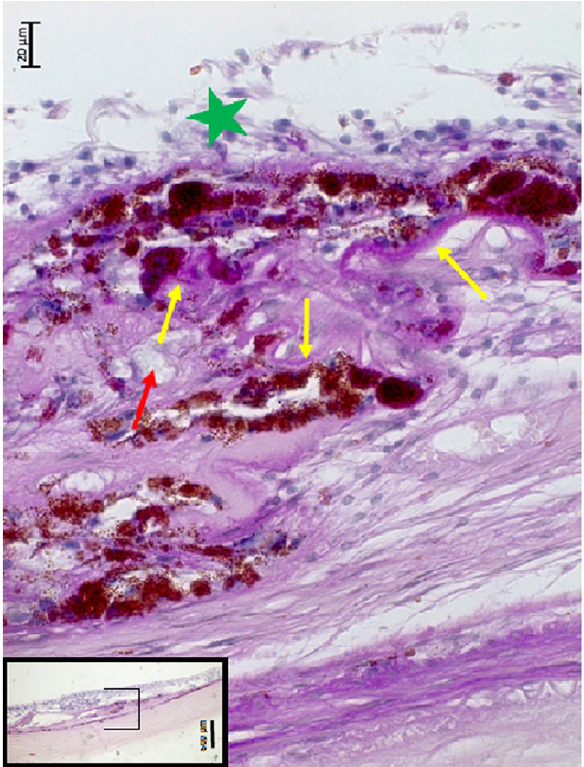
Figure 1. Histophotograph showing a neovascular myopic macular degeneration with irregular proliferations of irregularly pigmented retinal pigment epithelium cells, each of which connected with a PAS (Periodic-Acid- Shiff)-positive, crumbled basal membrane (yellow arrows), retinal capillaries (red arrow), and fibrous tissue, located beneath a disarranged retina (green